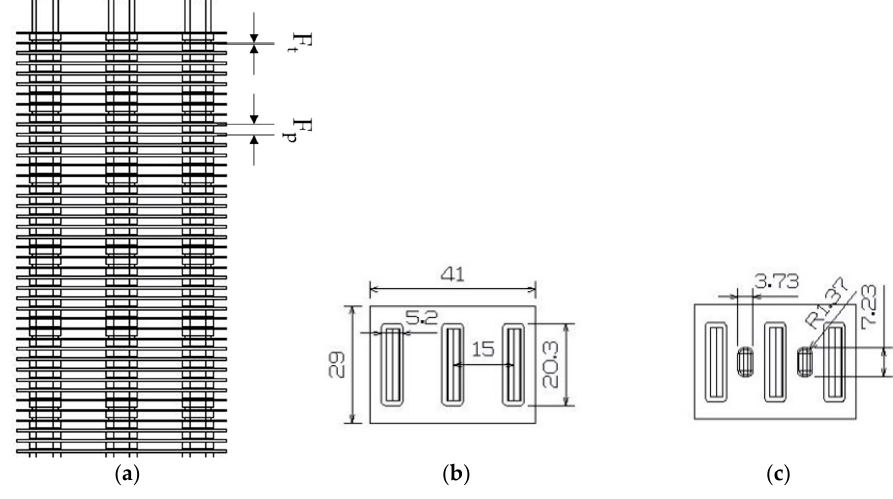
Figure 8. Physical model of high-voltage PTC heater. ( a ) Schematic view of PTC heat core; ( b ) Plate fin; ( c ) Emboss fin. Table 4. Specification of physical model.